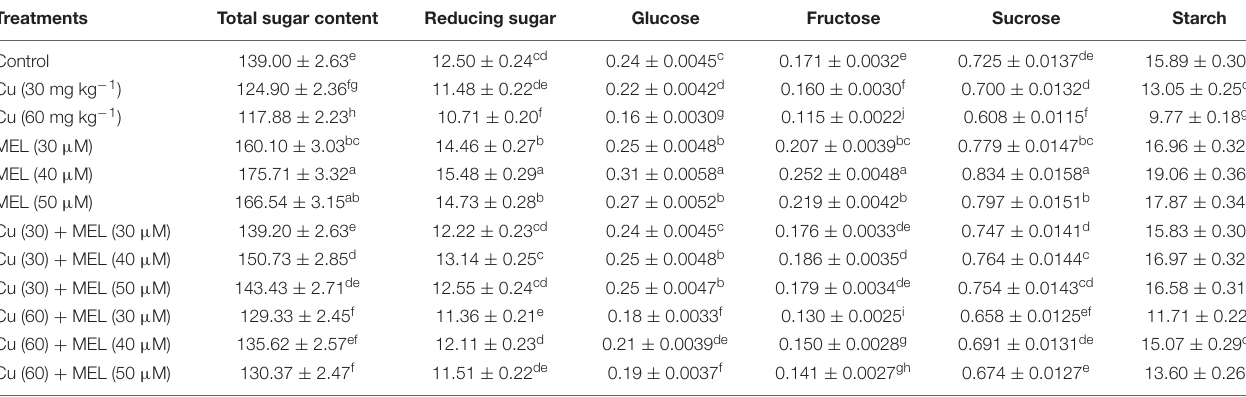
TABLE 4 | Effect of different levels of soil applied Cu (0, 30, or 60 mg kg − 1 ) and/or MEL (30, 40, or 50 µ M) on total Soluble sugar (mg g − 1 DW), reducing sugar (mg g − 1 DW), glucose (mg g − 1 FM), fructose (mg g − 1 FM), sucrose (mg g − 1 FM), and starch (mg g − 1 FM) content in Brassica juncea at 45 DAS.